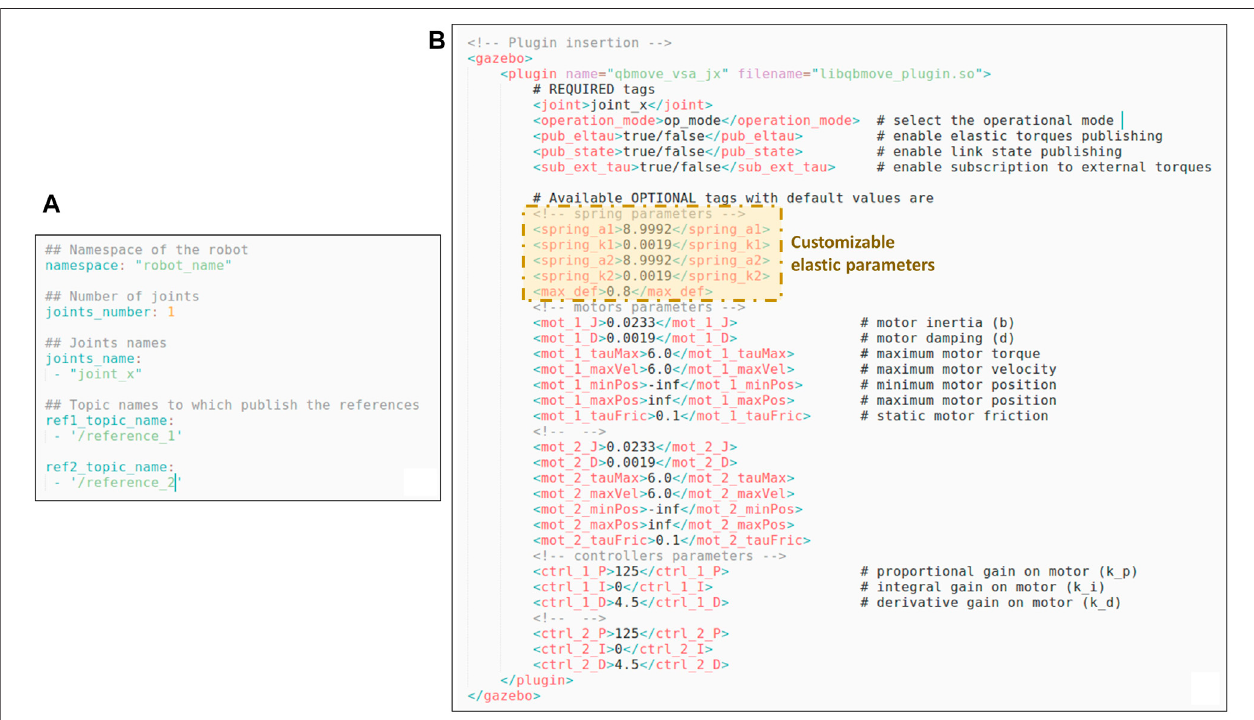
FIGURE6| Panel (A) showsanexampleofthecon fi guration fi lerequiredbythe PluginManager node,whileinpanel (B) thetemplateforinsertingthepluginrelative to the qbMove Advanced discussed in Section 3.1.3 , is reported. It is worth noting that, besides required tags for the plugin, there are also optional tags that the users can de fi ne to modify the motor and controller parameters. Furthermore, there are customizable parameters that depend on the elastic functions implemented in the compliance model.